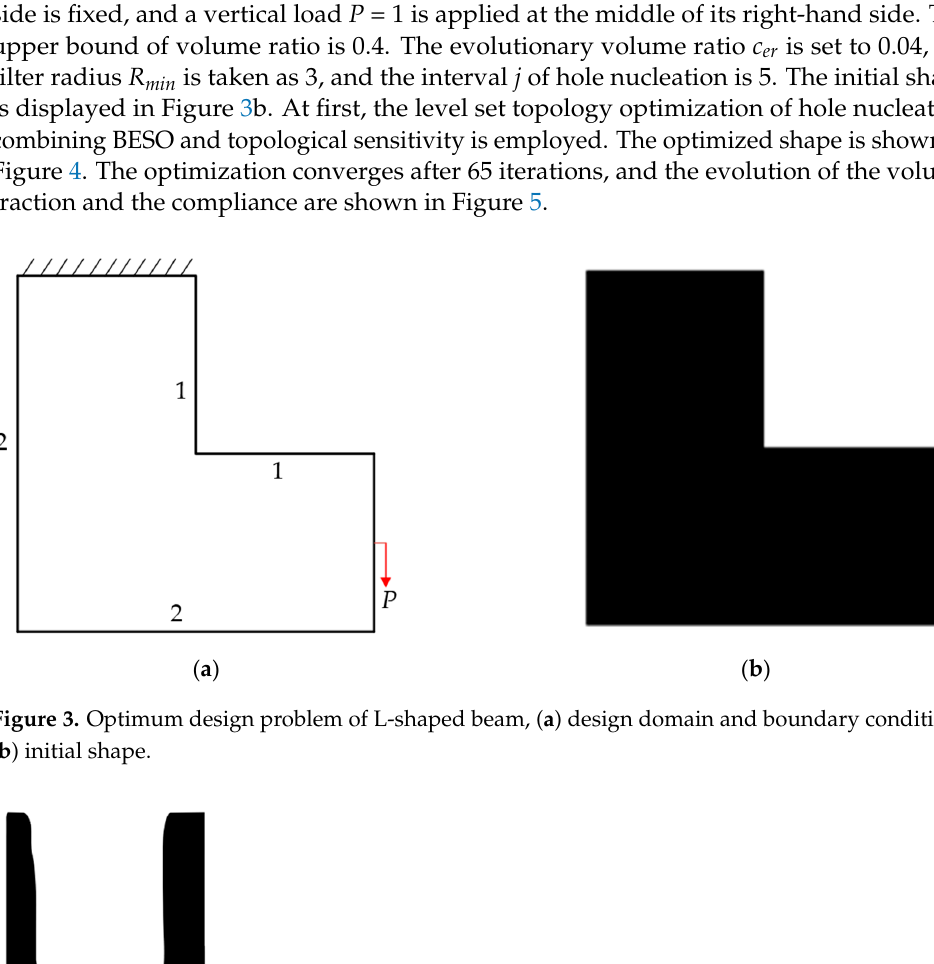
Figure 4. Preliminary optimized shape of L-shaped beam.